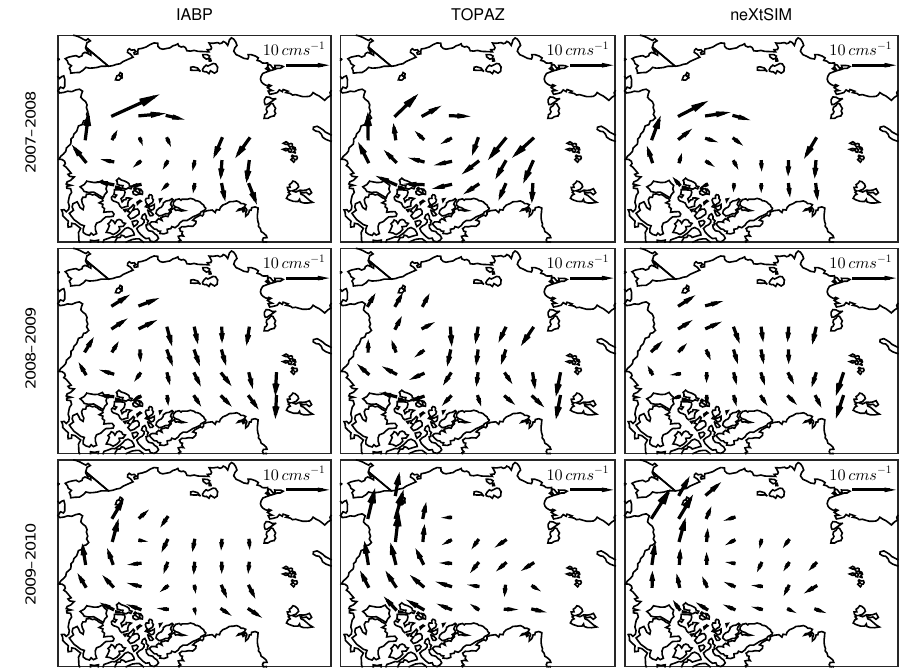
Figure 7. Mean sea-ice velocity field computed from the IABP buoys dataset (left), the corresponding float dataset generated with TOPAZ (center) and neXtSIM (right) for the winters 2007/2008 (top), 2008/2009 (middle) and 2009/2010 (bottom). The mean velocity vectors are computed with the averaging scales L = 1000km and T = 250 days and are shown on a 400 × 400km regular